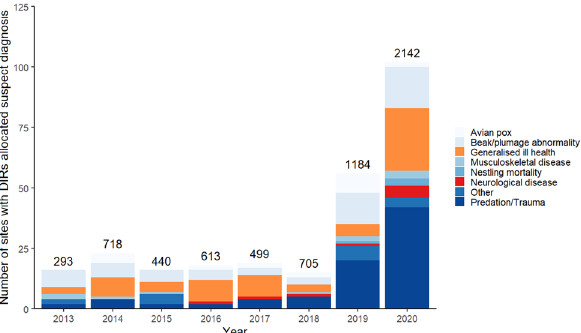
Figure 2. Number of sites from which Eurasian blackbird ( Turdus merula ) disease incident reports (DIRs) were submitted in Great Britain by syndromic disease surveillance category, June–November inclusive, 2013–2020 (n = 265); improved reporting was implemented in 2019*. Data labels indicate total number of sites from which passerine DIRs were submitted in respective years. *Whilst the number of blackbird morbidity reports was relatively consistent across the period 2013–2018 inclusive, a marked increase in the absolute number of DIRs occurred in 2019, which was reflected across the Passeriformes species, and for hedgehogs as a control group (Supplementary Fig. 2). This increase can be explained by a change in the online platform which prompted an increased number of reports made by participants in the GBW scheme. A further increase in the scale of reporting occurred in 2020, again across garden wildlife species, is accounted for by the COVID-19 pandemic, with more people working from home and observing wildlife in their gardens and immediate surrounding